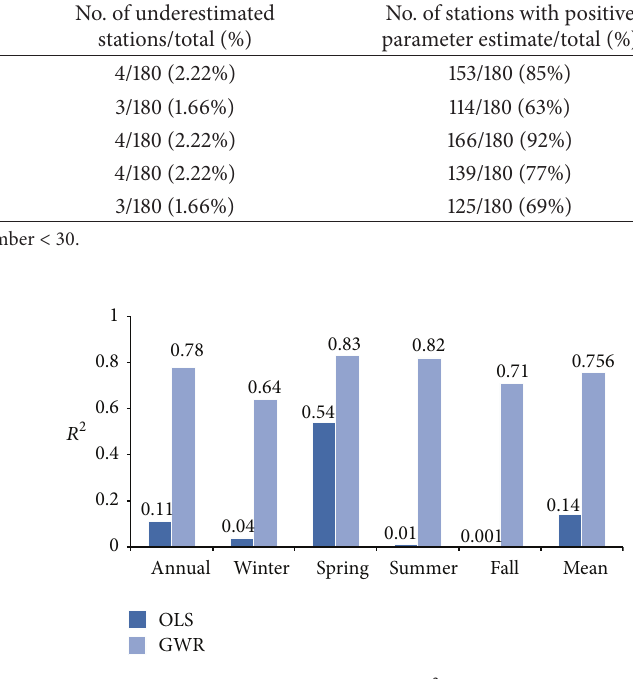
Figure 7: Coefficient of determination (𝑟 2 ) derived by OLS and GWR